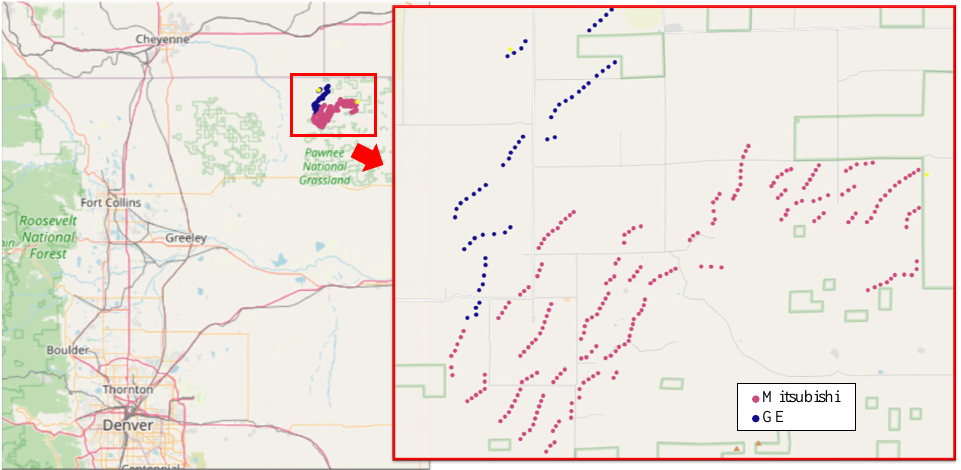
Figure 2. Locational distribution of the Mitsubishi and GE wind turbines in the wind farm.